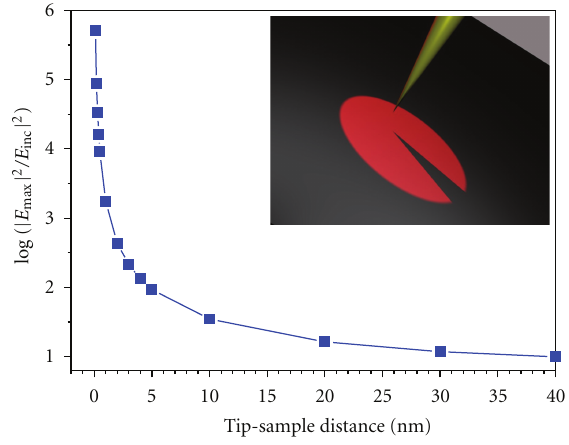
Figure 7: Raman enhancement factor estimated by Finite Elements Analysis (FEA) in the vicinity of the surface of interest, as a function of the tip-surface distance (0.1 to 40 nm). The inset shows the tip approach from the incident beam and the shadowing of the incident beam during the approach